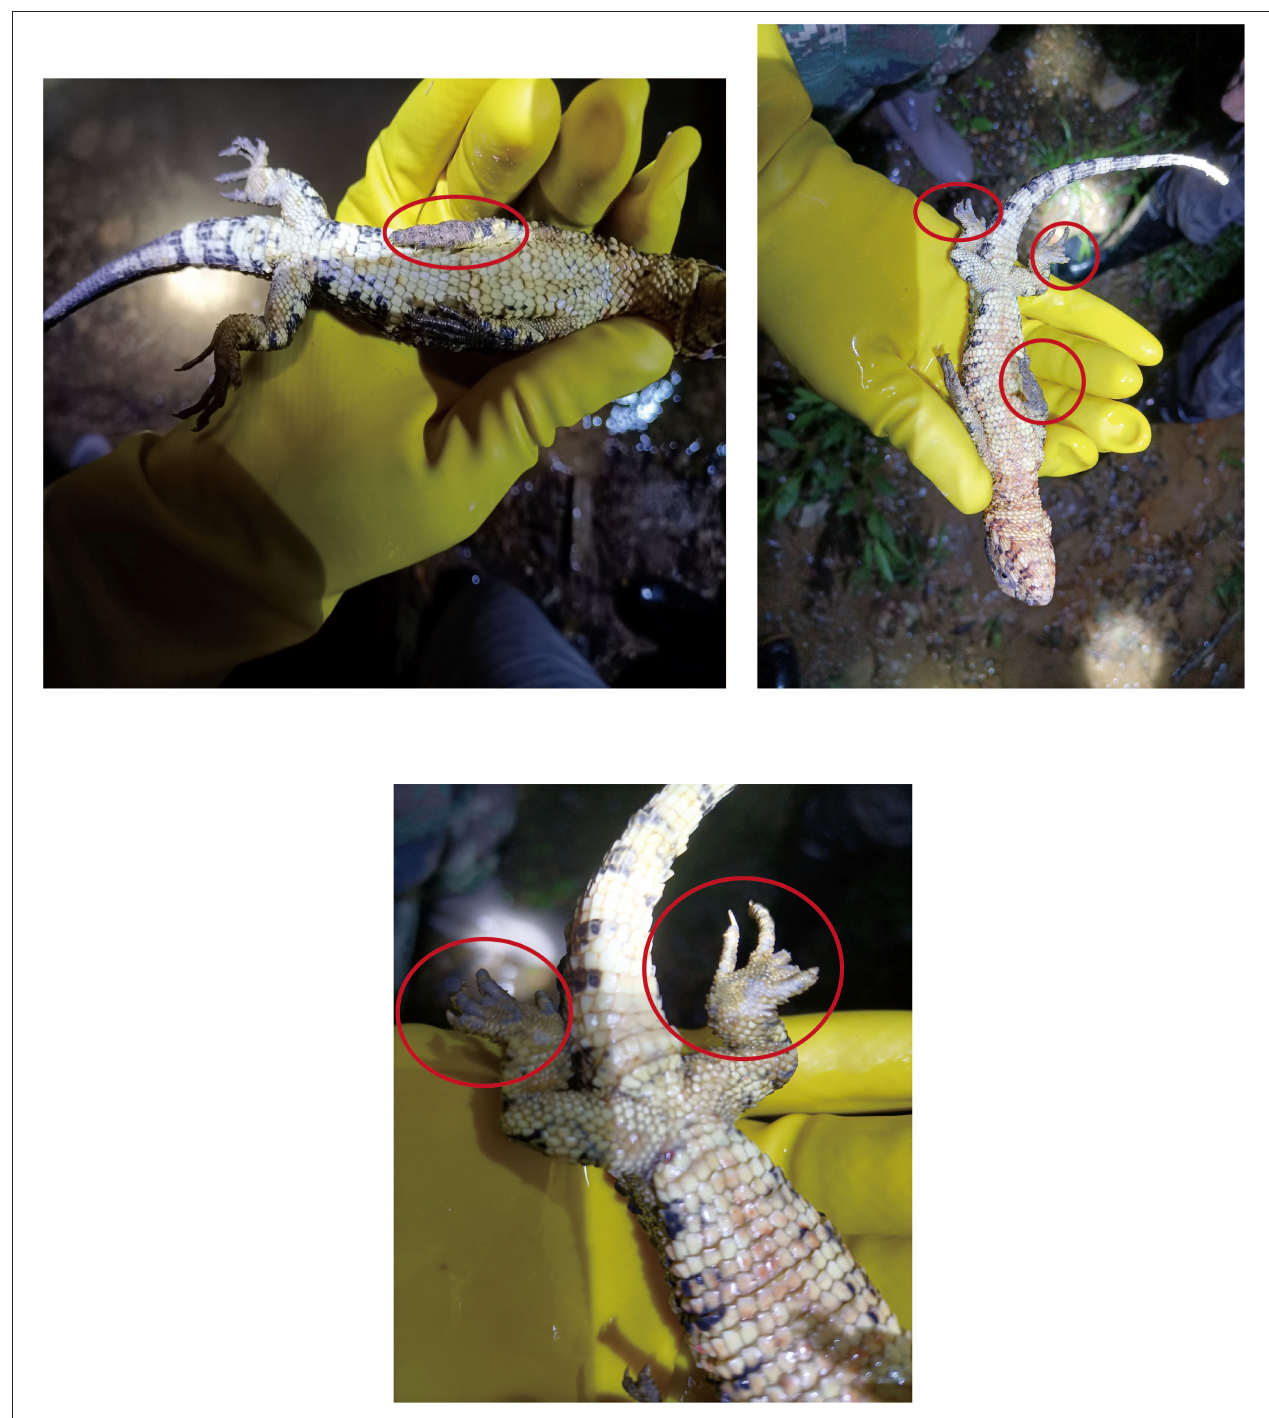
FIGURE 4 | Typical wild case found in 2019 in Yusanchong of Daguishan National Nature Reserve, Hezhou, China. Infection wound is highlighted by a red circle and showed high similarity to captive cases.